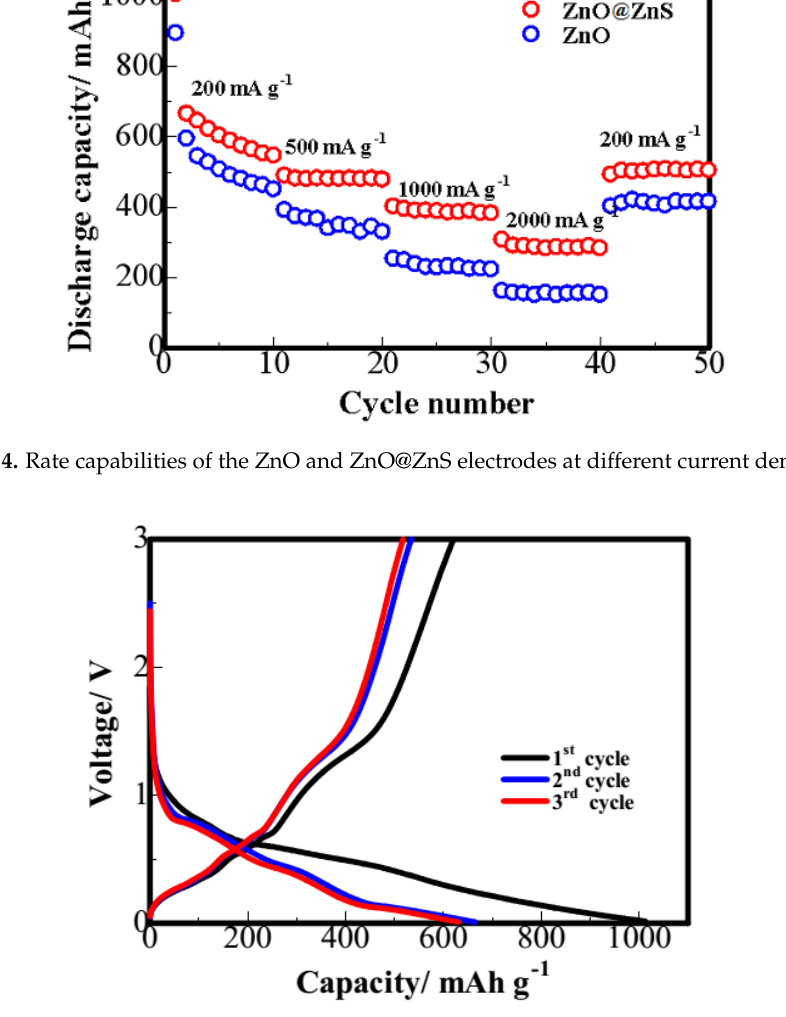
Figure 5. Galvanostatic charge-discharge voltage profiles of the ZnO@ZnS nanorod electrodes at a current density of 200 mA g − 1